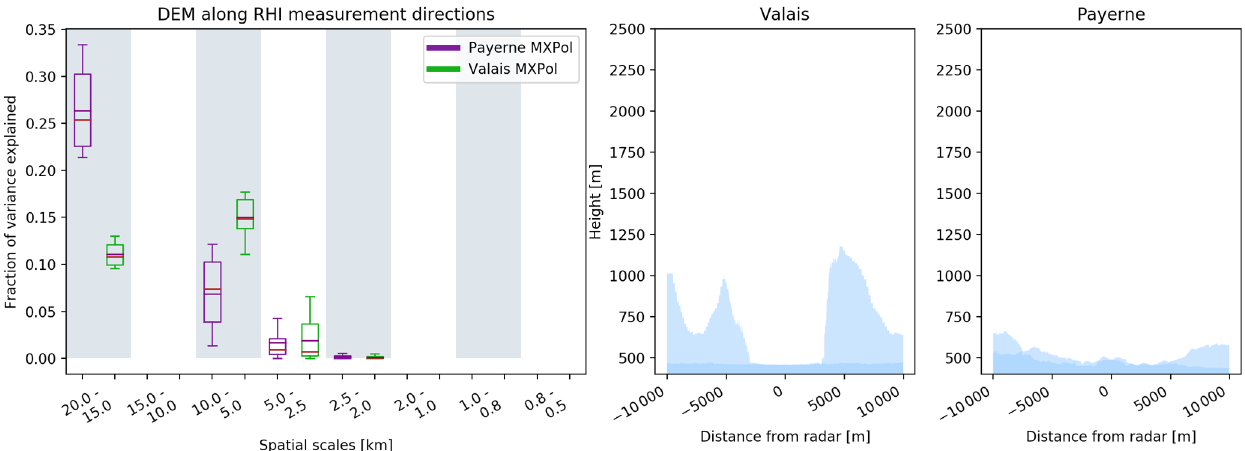
Figure 13. Box plots of the fractions of variance explained by components (binned) for the 10 transects extracted from the DEM data in the direction of the RHI scans ( ± 5 ◦ azimuth) with the first and last transect of the DEM in a clockwise direction (measurement direction − 5 ◦ and measurement direction + 5 ◦ azimuth) in the right hand